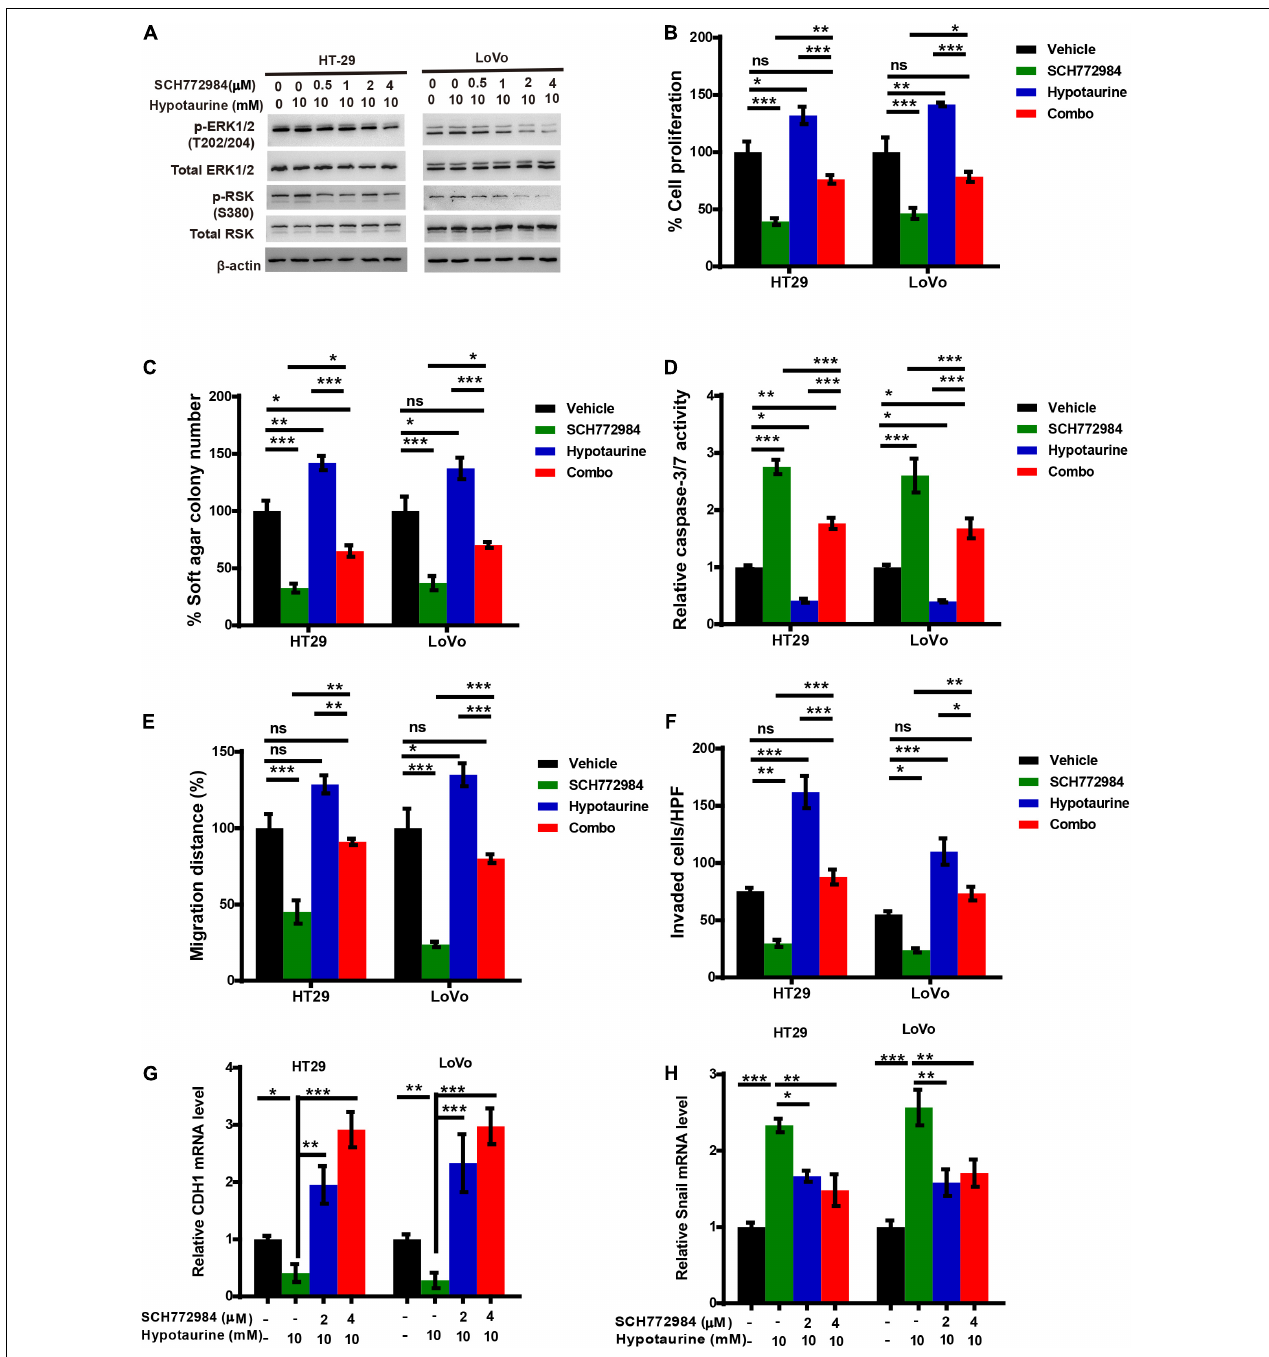
FIGURE 6 | An ERK/RSK inhibitor reverses the promoting effects of hypotaurine on tumor progression and EMT in CRC cells. (A) The effects of ERK/RSK inhibitor (SCH772984) on the phosphorylation (denoted p-) status of ERK and RSK were detected with western blotting analysis. (B) The proliferative rates of CRC cell lines after treatment with SCH772984 (2 µ M) and/or hypotaurine (10 mM) (means ± SEM) (one-way ANOVA followed by Tukey’s post hoc test, * P < 0.05, ** P < 0.01, *** P < 0.001). (C) Quantification of clones formed by the indicated CRC lines after treatment with SCH772984 (1 µ M) and/or hypotaurine (5 mM) for 3 weeks (means ± SEM) (one-way ANOVA followed by Tukey’s post hoc test, * P < 0.05, ** P < 0.01, *** P < 0.001). (D) The proapoptotic effects of SCH772984 (2 µ M) and/or hypotaurine (10 mM) on CRC cells were observed with caspase 3/7 reporter assay (means ± SEM) (one-way ANOVA followed by Tukey’s post hoc test, * P < 0.05, ** P < 0.01, *** P < 0.001). (E) The cellular migratory effects of SCH772984 (2 µ M) and/or hypotaurine (10 mM) on CRC cells were determined by wound-healing assay and quantified. (means ± SEM) (one-way ANOVA followed by Tukey’s post hoc test, * P < 0.05, ** P < 0.01, *** P < 0.001). (F) The cellular invasive effects of SCH772984 (2 µ M) and/or hypotaurine (10 mM) on CRC cells were ascertained by transwell invasion assay and quantified (means ± SEM) (one-way ANOVA followed by Tukey’s post hoc test, * P < 0.05, ** P < 0.01, *** P < 0.001). (G,H) The effects of SCH772984 and/or hypotaurine on EMT markers in CRC cells were discerned using qRT-PCR (means ± SEM) (one-way ANOVA followed by Tukey’s post hoc test, * P < 0.05, ** P < 0.01, *** P < 0.001).